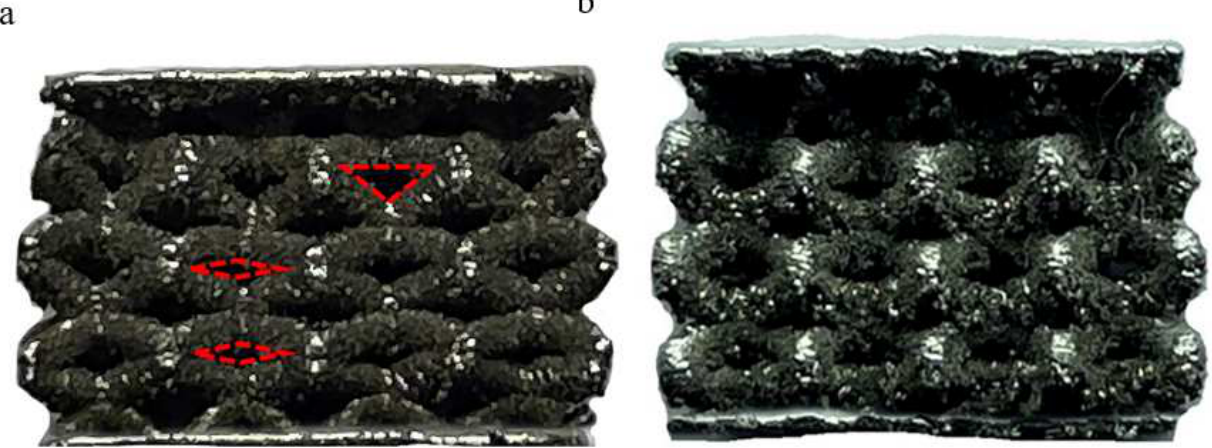
Figure 5. Compression test results: ( a ) conventional BCC structure and ( b ) optimized BCC structure.